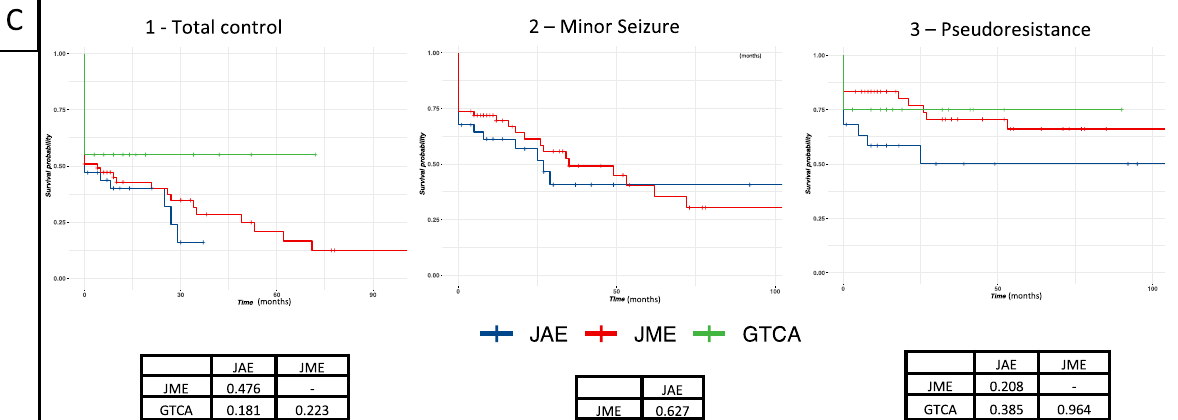
presented exclusively with GTC seizures, and all these them had awake and sleep EEG findings with generalized